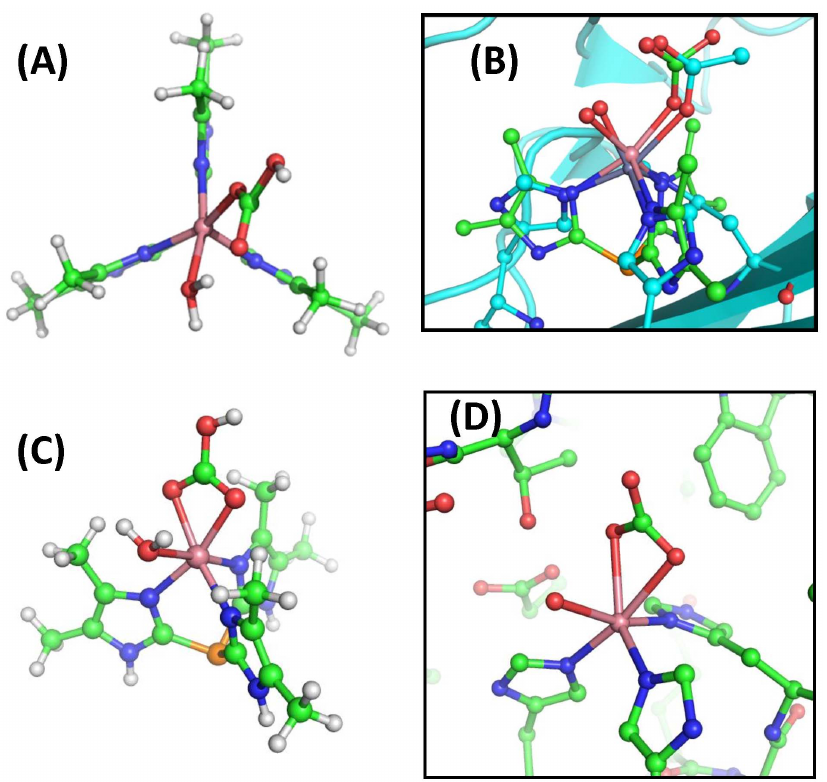
Figure 6. Optimized structures of Ph-Co-bicarbonate-water complexes. Panel (A) shows the low energy structure of Ph -Co interacting with water (I3). Panel (B) shows an overlay of the Ph -Co (I3, green) structure with the wild-type (zinc) carbonic anhydrase with acetate (1XEG, cyan). Panel (C) shows an octahedral geometry for bicarbonate, and water bound to cobalt. Panel (D) shows the arrangement of ligands (water and bicarbonate) around the metal ion in the X-ray crystal structure of cobalt carbonic anhydrase